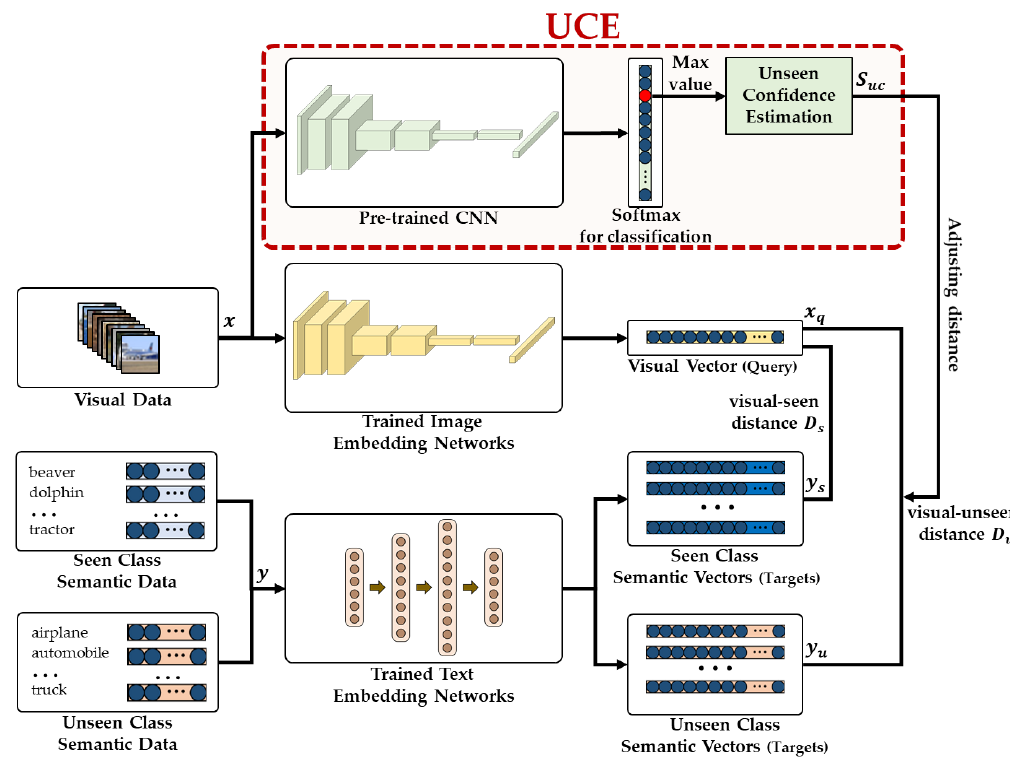
Figure 3. Generalized zero-shot inference architecture with unseen confidence estimator.